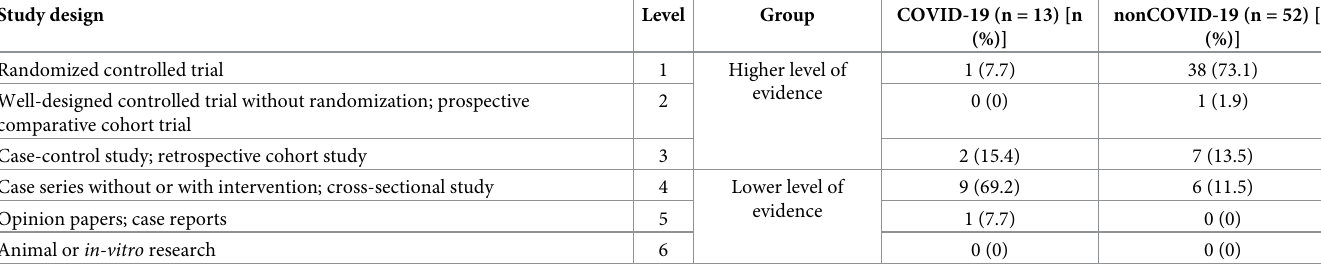
Table 2. Frequency distribution of the original articles on the levels of evidence pyramid [23,